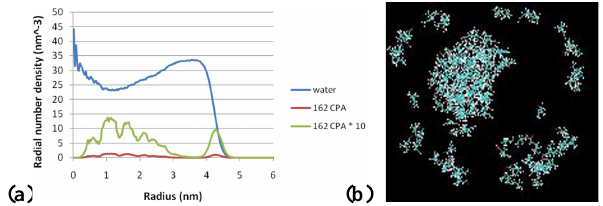
Fig. 4. (a) Radial number density showing two main peaks at 1.1 and 4.2nm. The green line is the radial number density of the CPA molecules multiplied with a factor of 10. (b) System containing 162 CPA molecules; cross-section